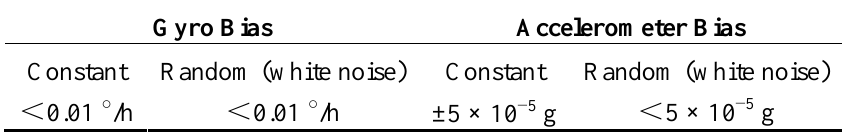
Table 11. The sensors precision of the strapdown inertial navigation system.